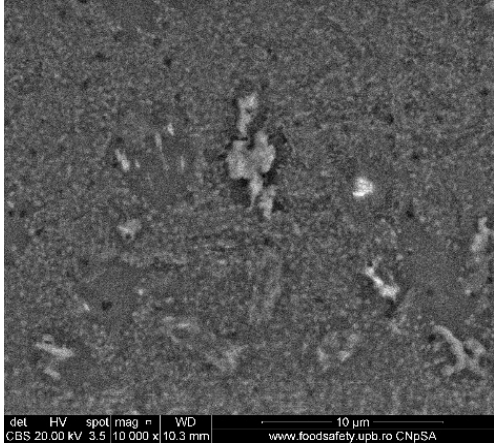
Figure 10. SEM image of 1.1%rGO-SiO 2 /glass.